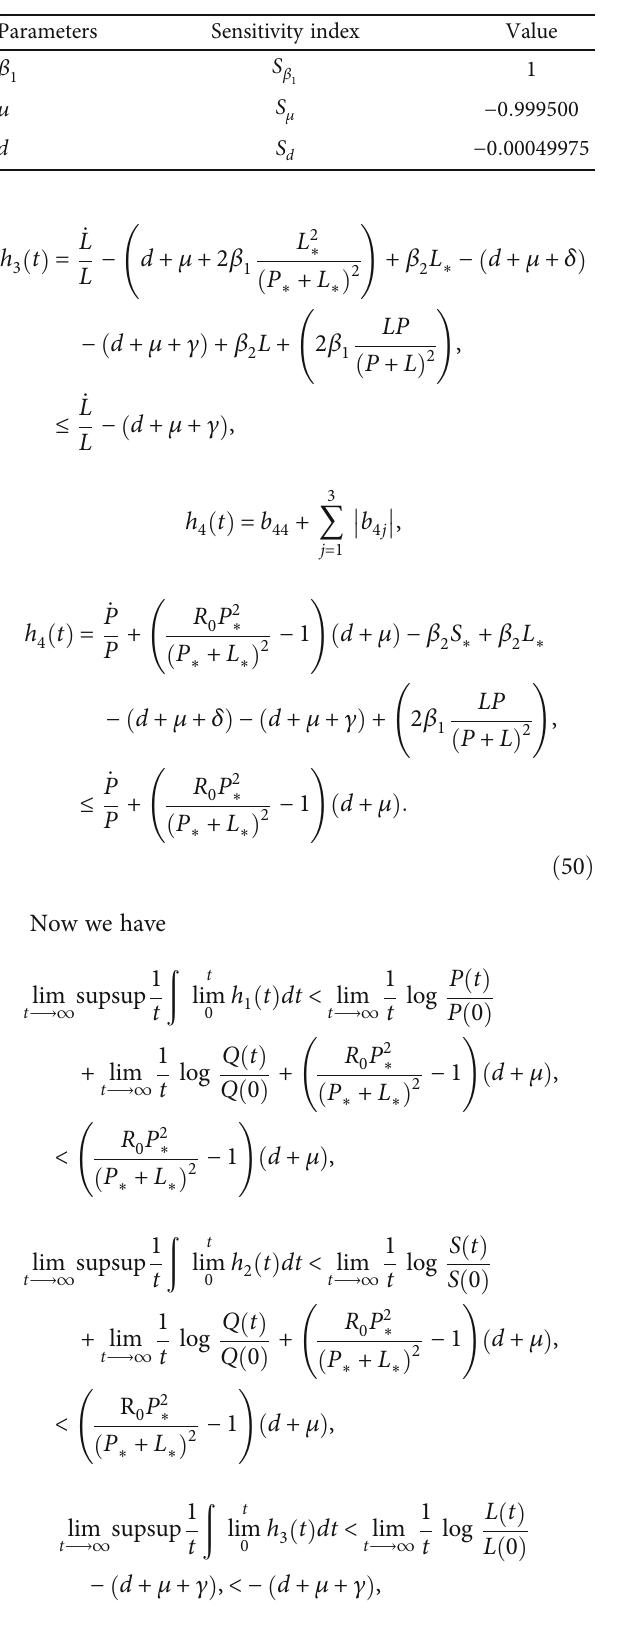
Table 2: Sensitivity indices of R and d